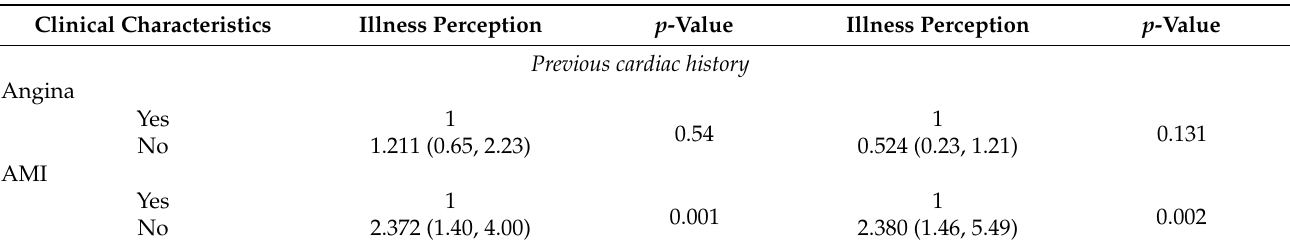
Table 5. Association of patients’ clinical characteristics and illness perception at